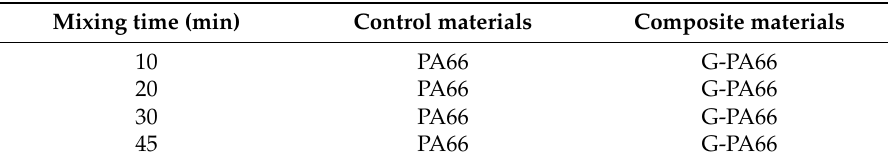
Table 1. Processing